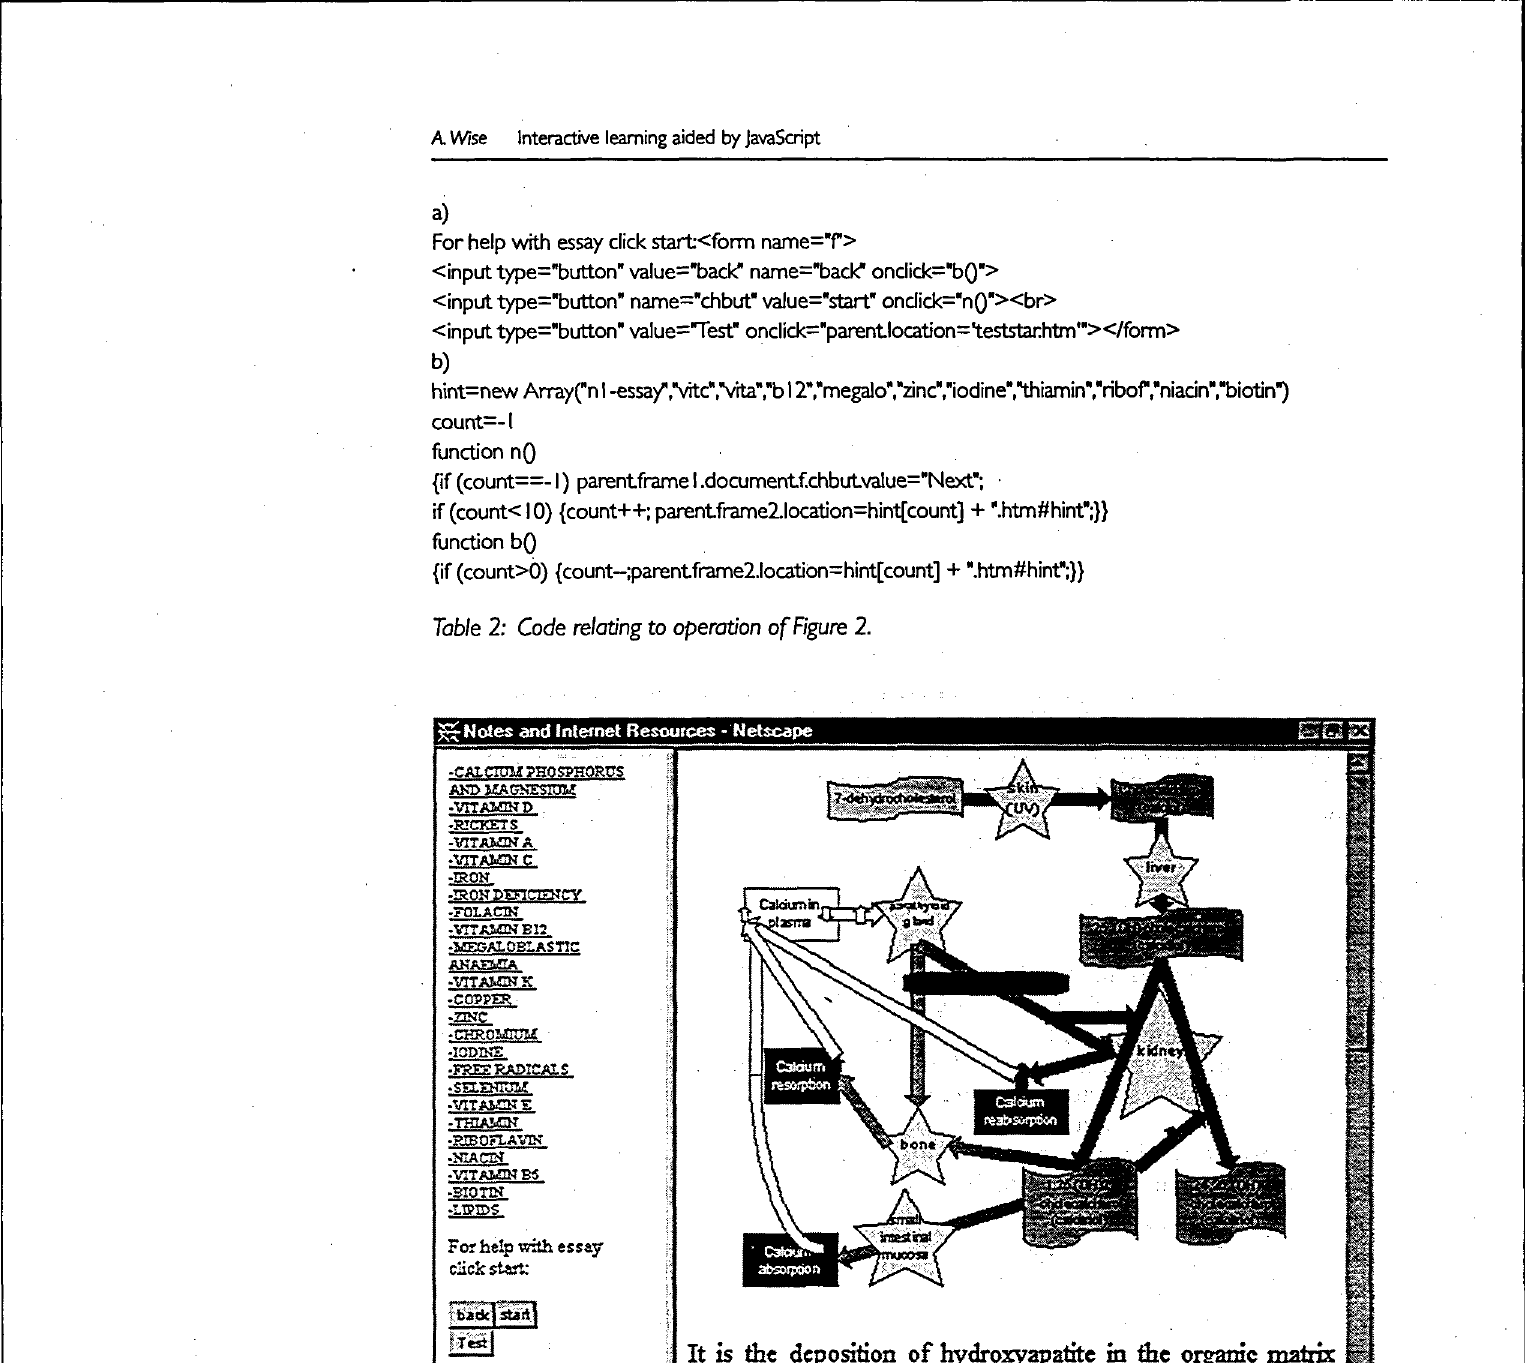
Figure 2: The presentation of lecture notes and